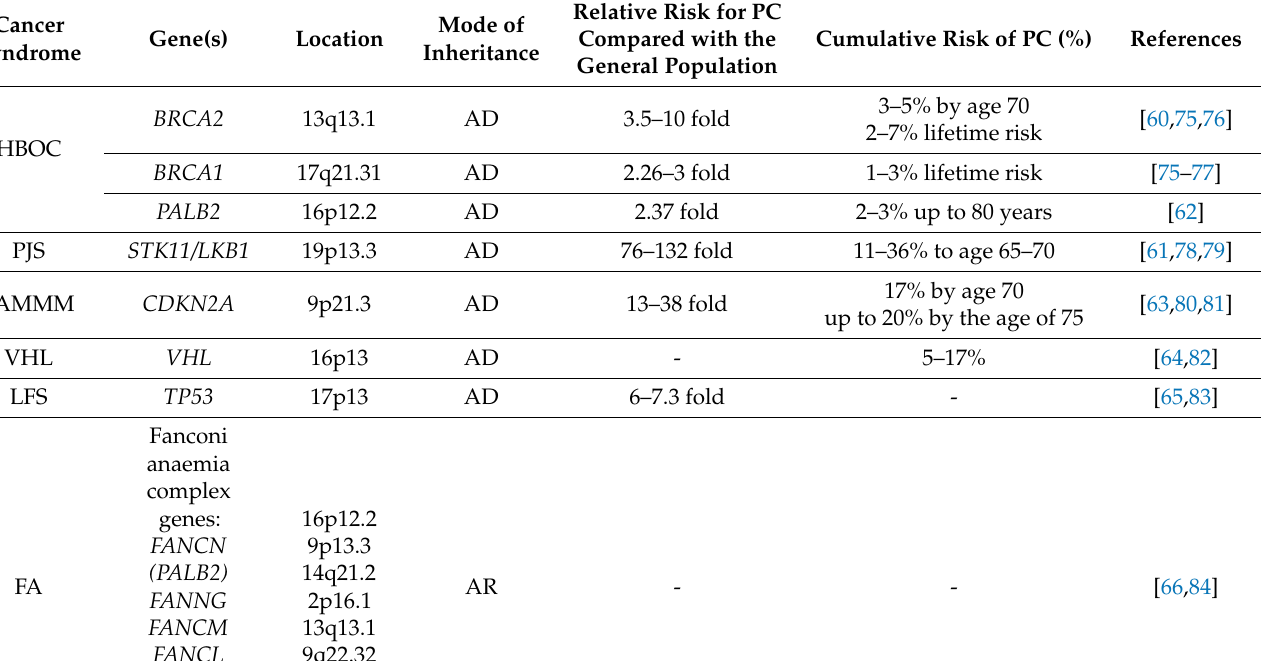
Table 2. Risk of development of pancreatic